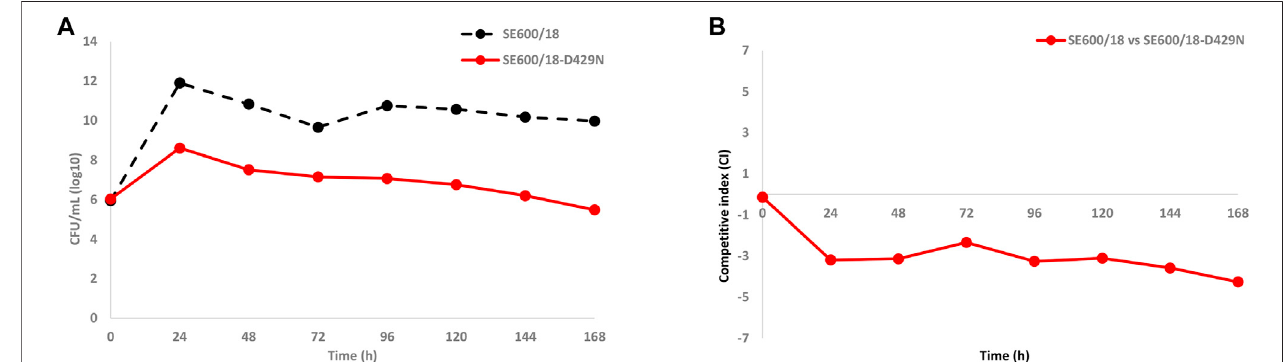
FIGURE 4 | (A) Growth curves of the total population of the zoli fl odacin-susceptible clinical Neisseria gonorrhoeae SE600/18 strain (black dashed line) and the zoli fl odacin-resistant N. gonorrhoeae SE600/18-D429N mutant (containing the pre-existing GyrB S467N amino acid substitution plus an in vitro selected D429N substitution; red solid line), when cocultured in the same Hollow Fiber Infection Model (HFIM) cartridge and followed for 7 days. (B) Competitive indexes for the zoli fl odacin-susceptibleclinical Neisseria gonorrhoeae SE600/18 strainand theoutcompeted zoli fl odacin-resistant N.gonorrhoeae SE600/18-D429Nmutant(red solid line), when cocultured in the same HFIM cartridge and followed for 7